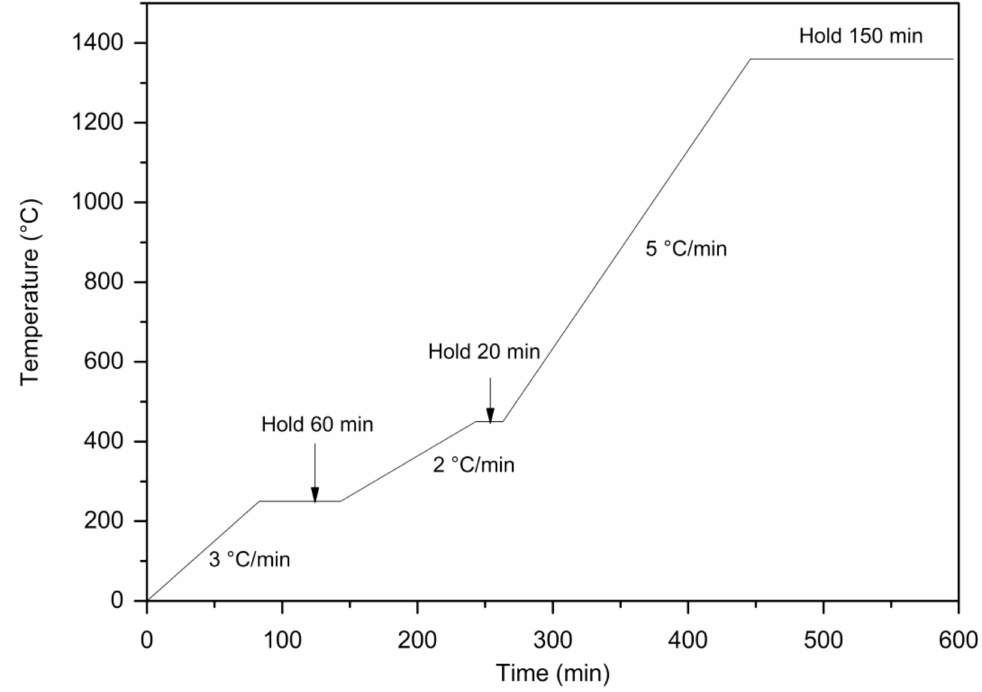
Figure 7. Thermal debinding and sintering profile optimized for AW-based feedstock (300 mbar,